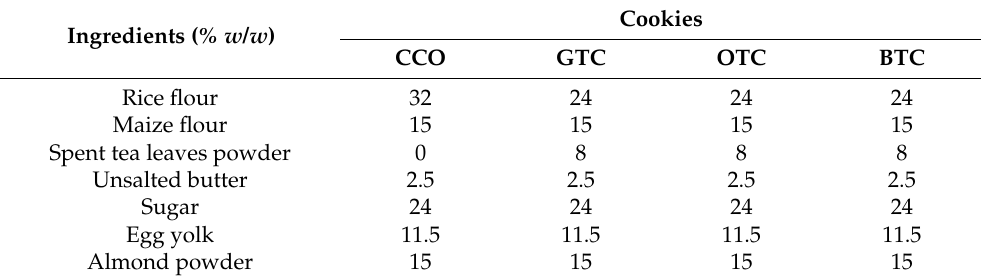
Table 1. Formulation of non-gluten shortbread cookies with various spent tea leaf powders. Ingredients ( % w / w )